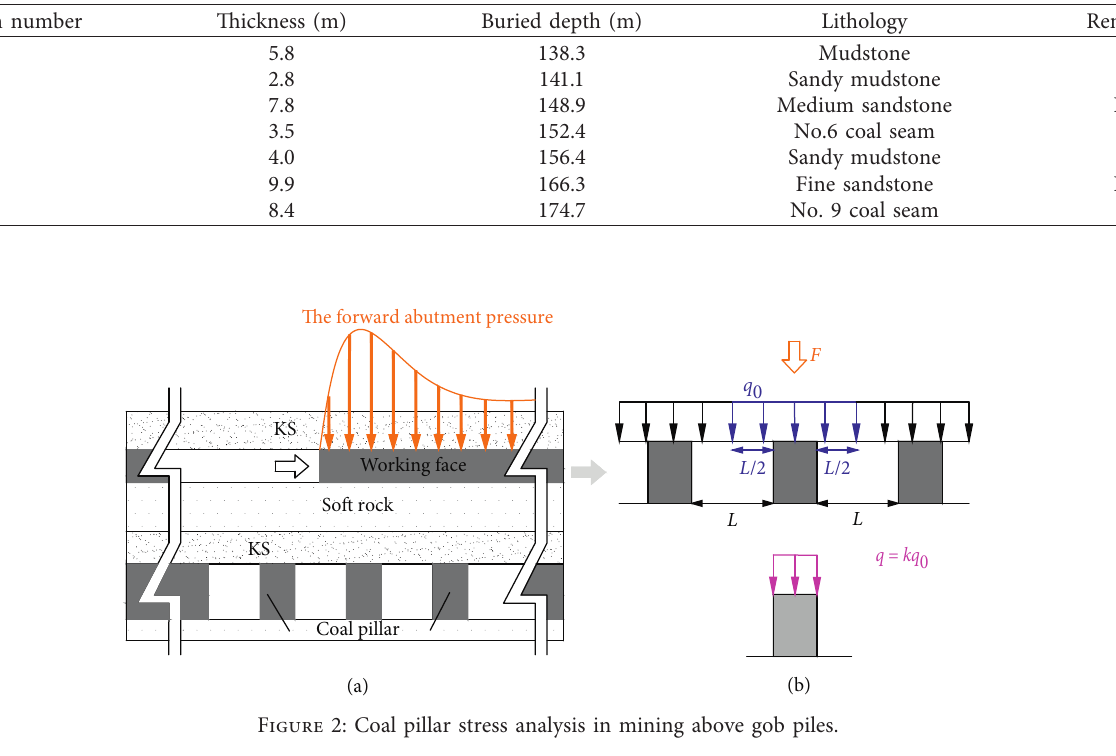
Figure 1: Positional layout of gob in the No. 9 coal seam and the No. 6107 working face in the No. 6 coal seam. Table 1: Thickness, burial depth, and lithology of the roof and floor.